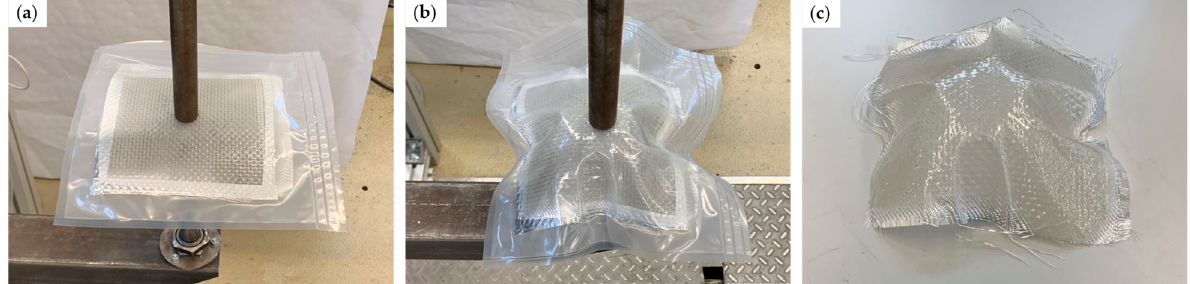
Figure 15. ( a ) Impregnated glass fiber fabric supported by metal wire mesh, enclosed in a vacuum bag and centrally clamped between two poles; ( b ) Material in vacuum bag after forming operations; ( c ) Formed glass FRP after curing.